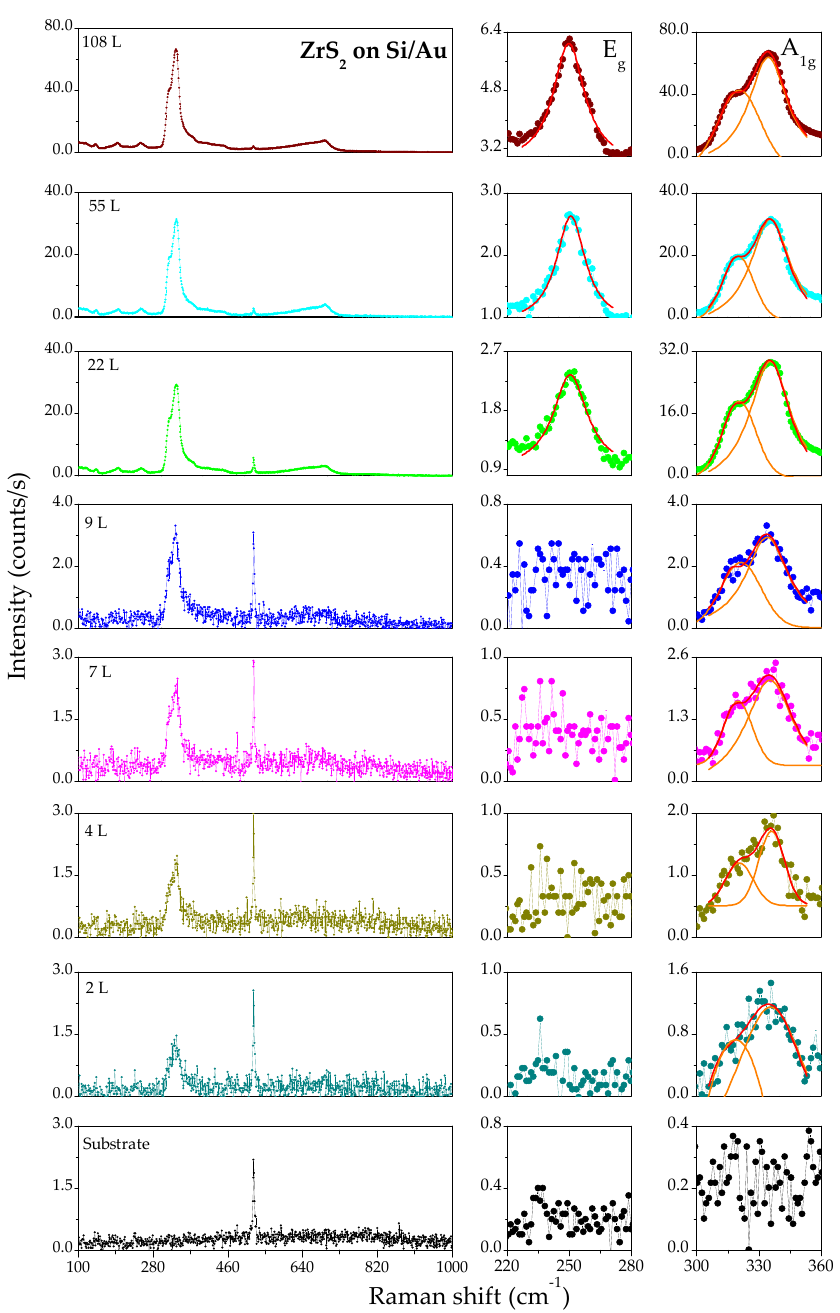
Figure C3. Thickness-dependence of the Raman spectra for ZrS 2 on a Si/Au substrate ( λ = 532 nm). Broad range spectra as well as zooms in the region of the A 1g and E g modes with their corresponding fitting are presented. Fitting results are given in Table C2.